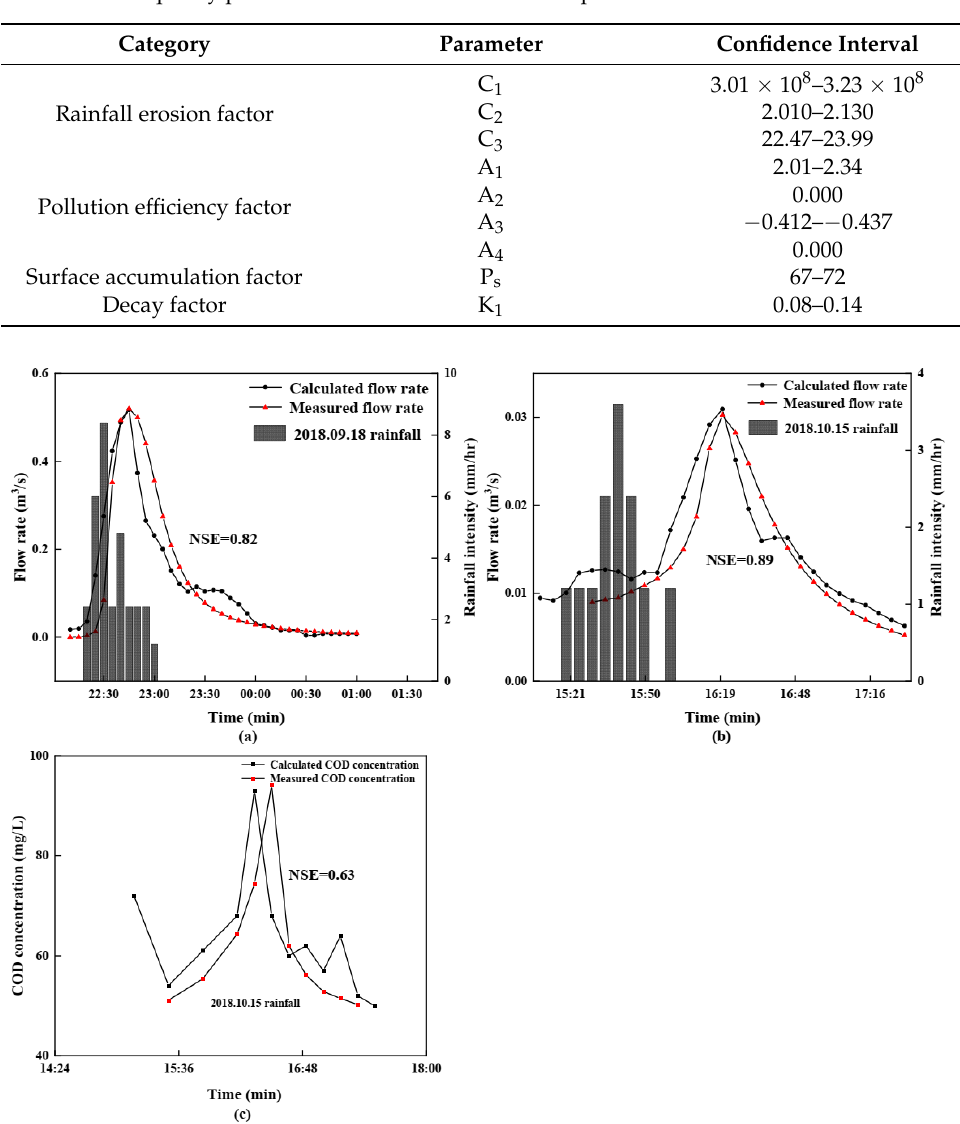
Table 2. Water quality parameter derived from calibration process.